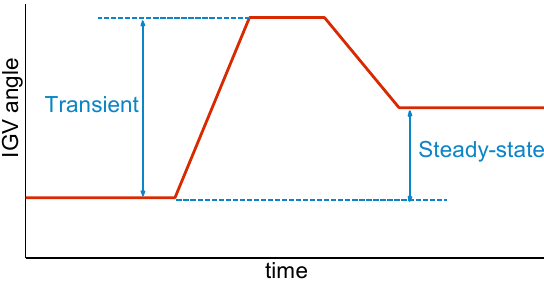
Figure 2. Schematic IGVs opening during frequency